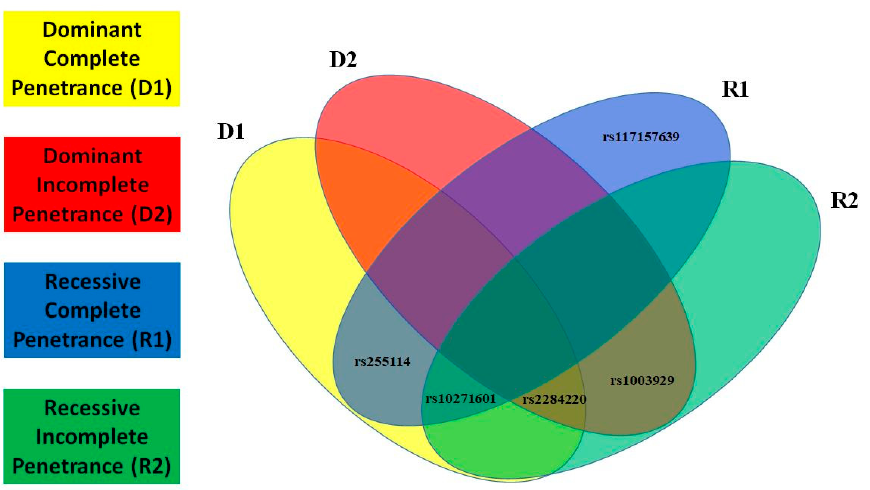
Figure 2. Type 2 Diabetes (T2D) CRHR2 -Risk Single Nucleotide Polymorphisms (SNPs). For each CRHR2 -risk SNPs in T2D, we present the − log 10 (P) as a function of each test statistic [Linkage, linkage disequilibrium (LD)|Linkage, LD|NoLinkage, Linkage|LD, and LD + Linkage] and per nucleotide polymorphisms (SNPs) lies in linkage-disequilibrium block or is independent, and the indication inheritance model: D1: dominant, complete penetrance, D2: dominant, incomplete penetrance, R1: whether the SNP was previously detected in MDD or T2D. 1 Models: D1: dominant, complete penetrance; recessive, complete penetrance, R2: recessive, incomplete penetrance.